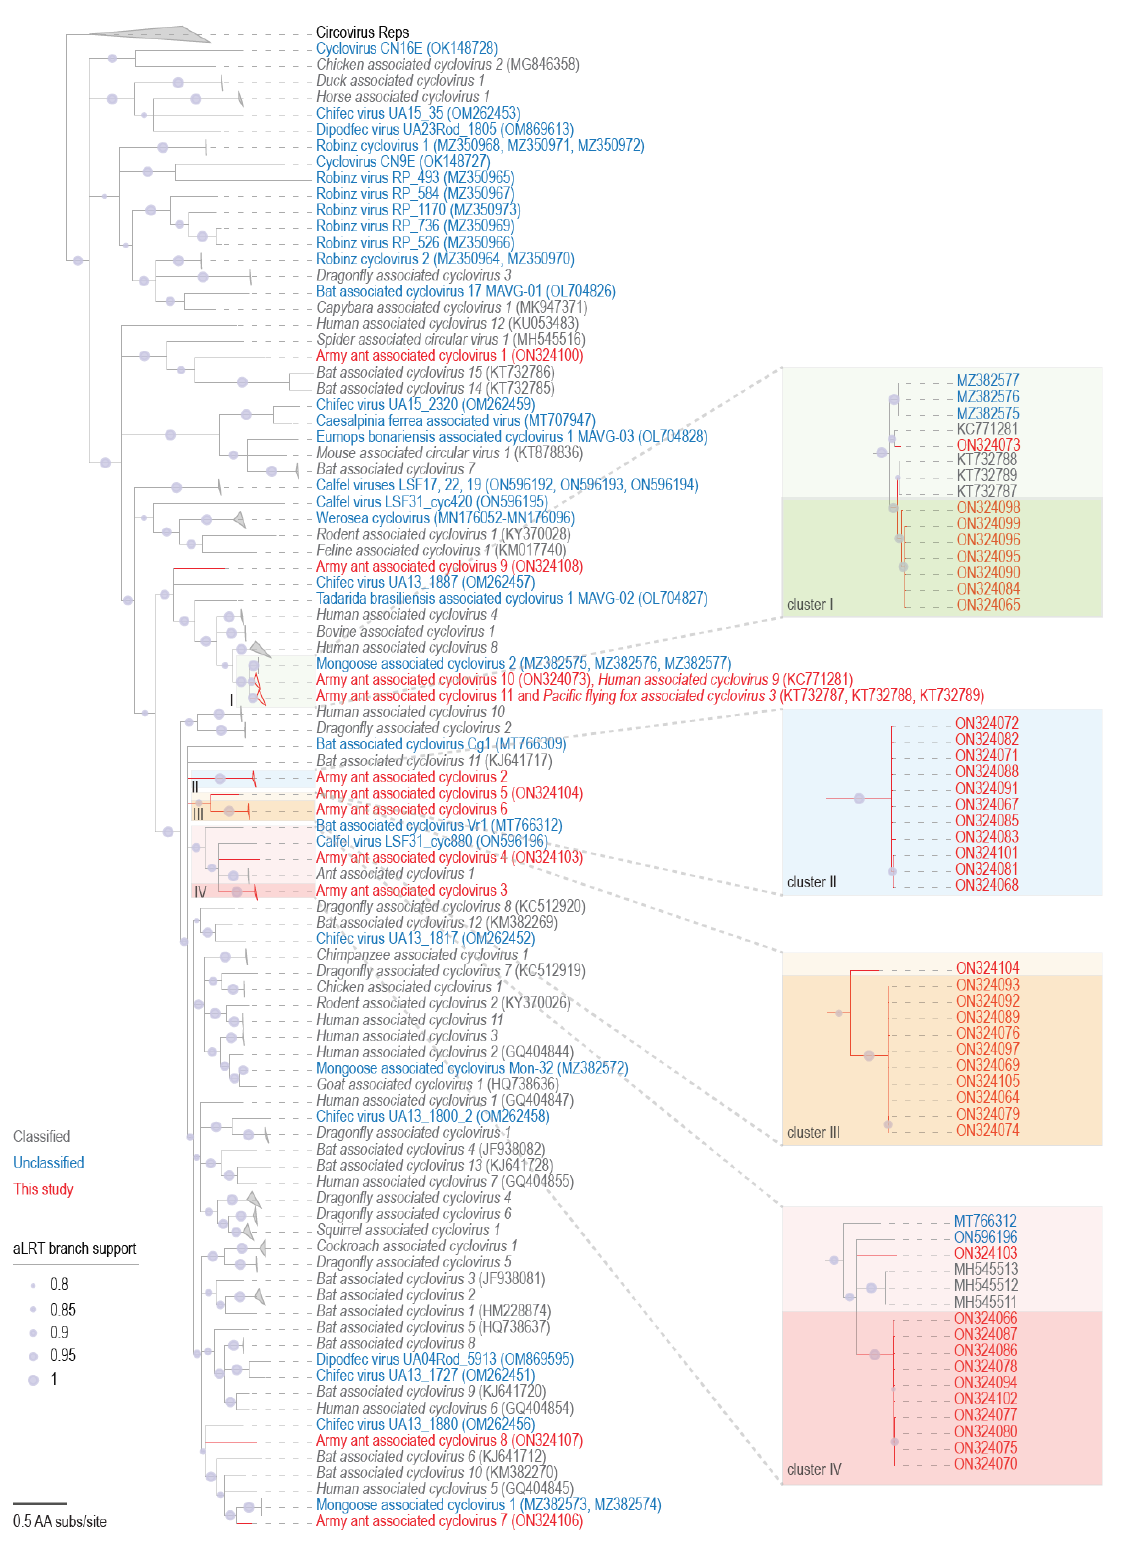
Figure 6 – Phylogeny of the cycloviruses. The maximum likelihood tree was generated using alignments of Rep protein sequences and the LG+I+G substitution model. Support for internal branches was assessed using the aLRT test (SH-Like). Branches in red, grey and blue refer to army ant- associated, classified and unclassified cyclovirus Rep sequences. The scale bar depicts the number of amino acid substitutions per site. Branches with <0.8 aLRT support have been collapsed with TreeGraph 2 (Stover & Muller, 2010). Zoomed-in views of four regions of the phylogenetic tree